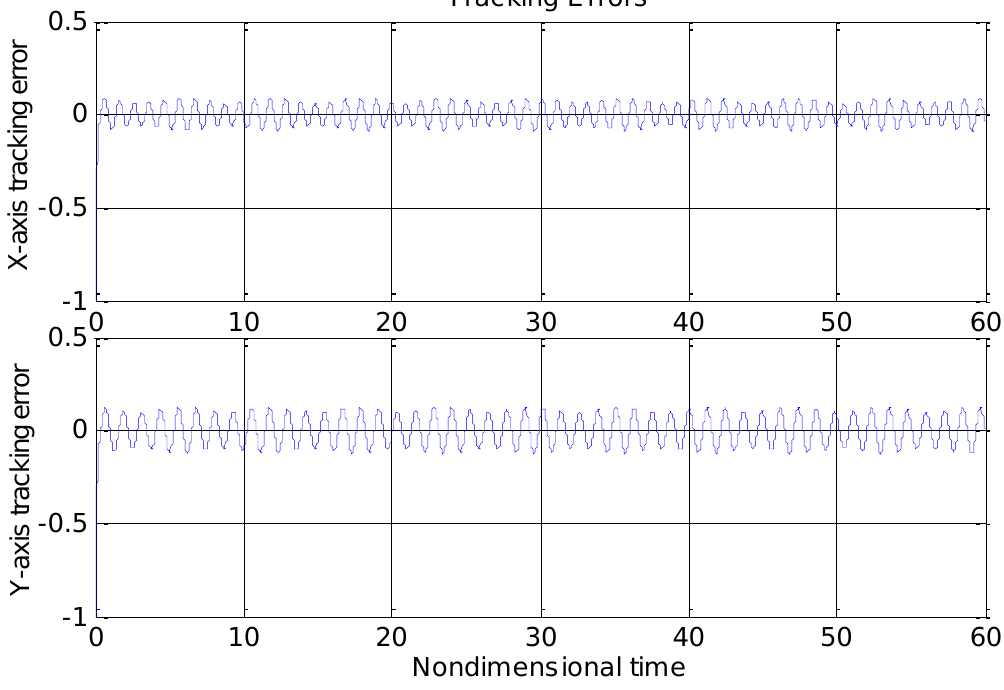
Figure 3. Tracking errors using a “dull” controller.